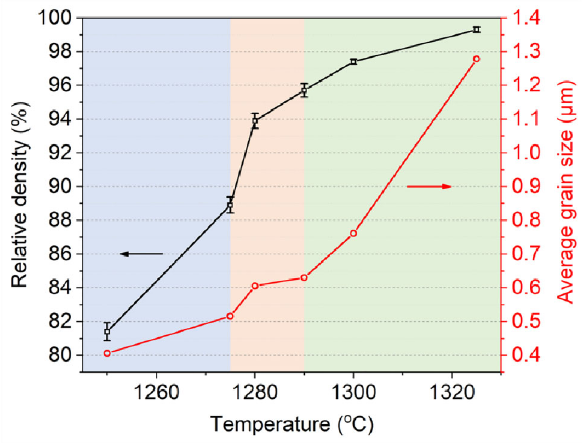
Fig. 4 Relative densities and average grain sizes as functions of air pre-sintering temperature for 8YSZ ceramics (holding time = 4 h).